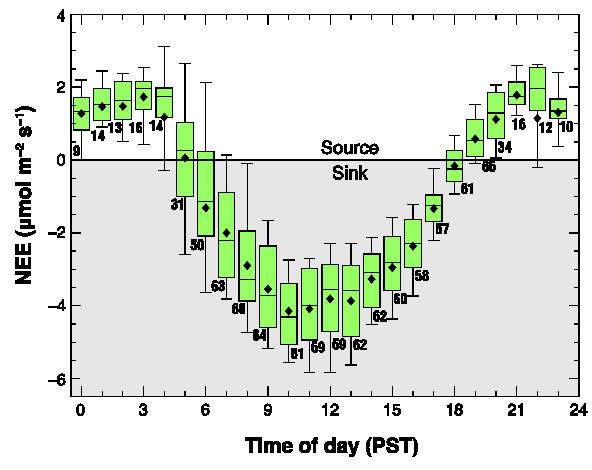
Figure 5. Ensemble-averaged diurnal course of eddy covariance (EC) measured net ecosystem exchange (NEE = ecosystem CO 2 flux) for the flux tower footprint between 09 July and 11 August 2014. The night-time u * threshold for data to be included was 0.08 m s -1 . The number of valid half- hour measurements averaged is indicated below each box and the boxes are defined as in Figure 3. The average daily (24-hour) NEE for the 34-day period was -0.94 µ mol m -2 s -1 with gaps filled using the mean diurnal variation